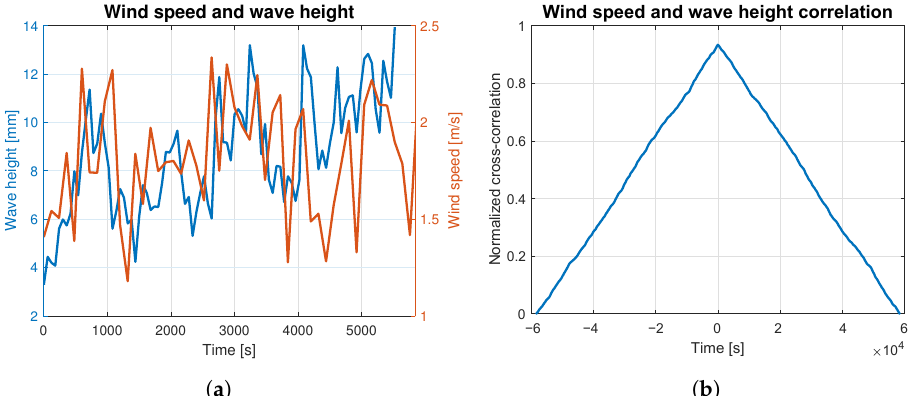
Figure 5. Wind speed and wave height correlation for 5 BFT: ( a ) wind speed and wave height measurements; ( b ) wind speed and wave height correlation.